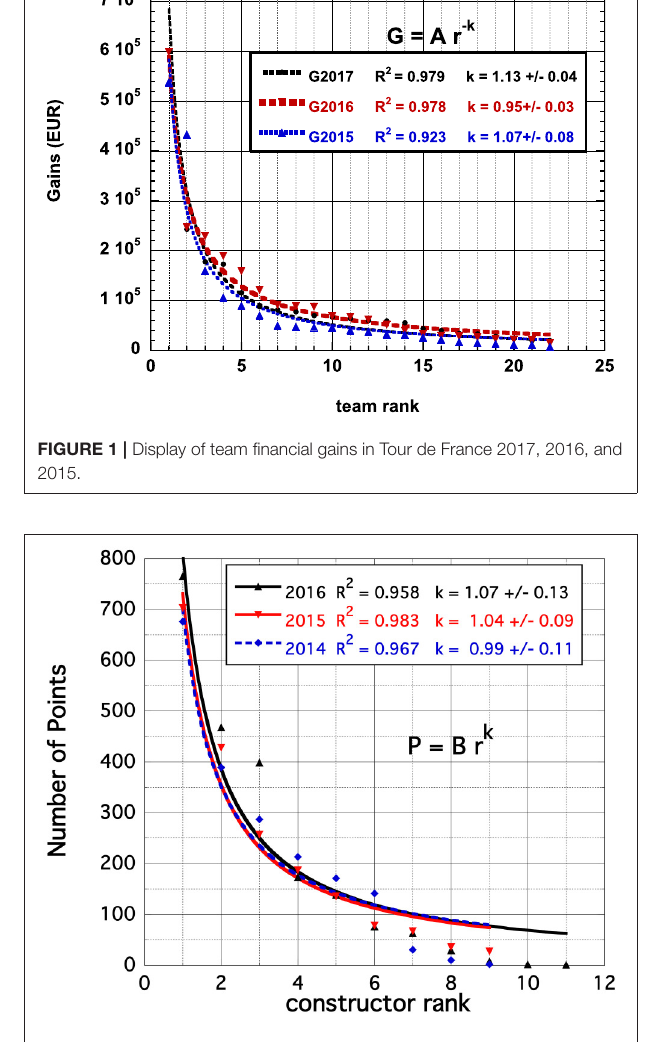
distribute, — whence there is less “advertisement” of the matter. This likely means that such a kind of (financial) data is not easily